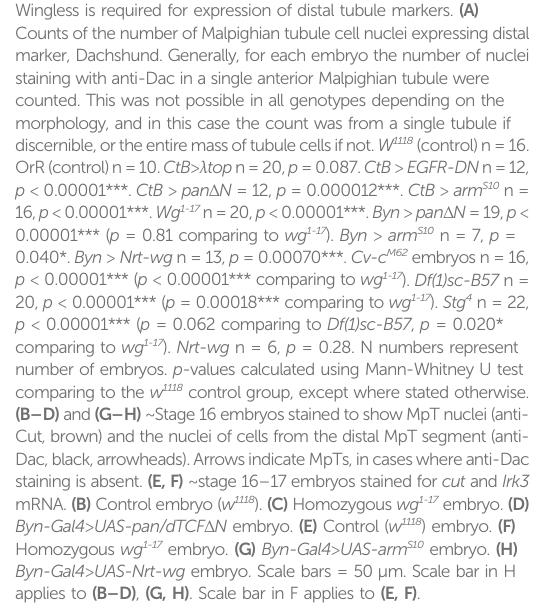
FIGURE 3 EGForWgpathwayactivitydonotappeartopatternthedistal Malpighian tubule. (A – E) ~Stage 16 embryos stained to show MpT nuclei (anti-Cut) and the nuclei of cells from the distal MpT segment (anti-Dac, arrowheads). In each example at least one of the pair of anterior MpTs is clearly visible. (A) Control ( w 1118 ) embryo. (B) CtB-Gal4 > UAS- λ top embryo. (C) CtB-Gal4 > UAS- EGFR-DN embryo. (D) CtB-Gal4 > UAS-pan/dTCF Δ N embryo. (E) CtB > UAS-arm S10 embryo. Scale bar = 50 μ m. FIGURE 4